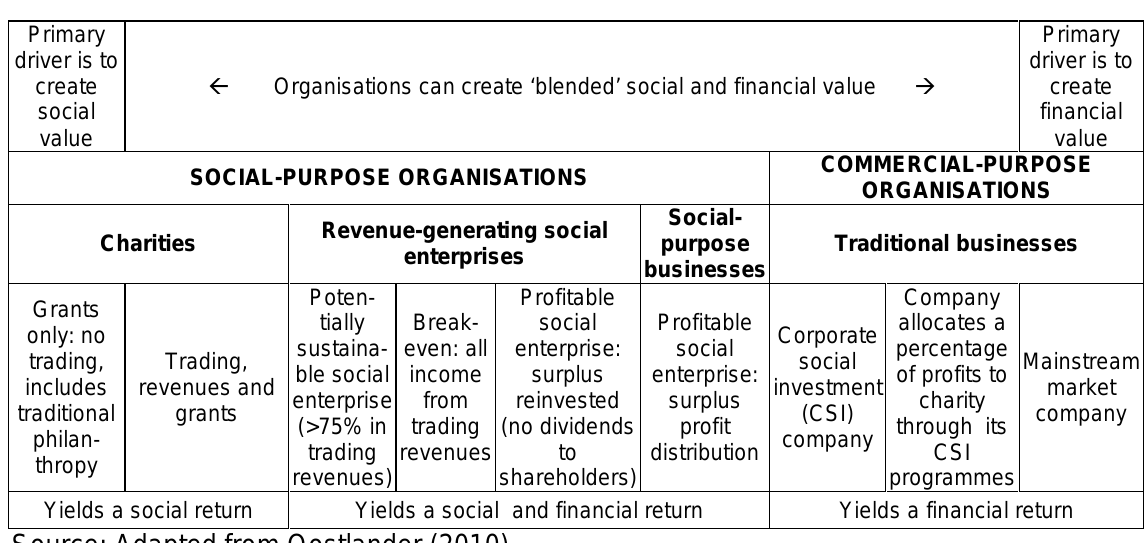
Table 1: The organisational-purpose